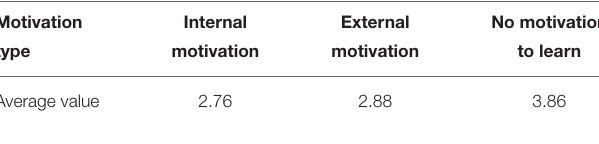
TABLE 1 | Students’ learning motivation.